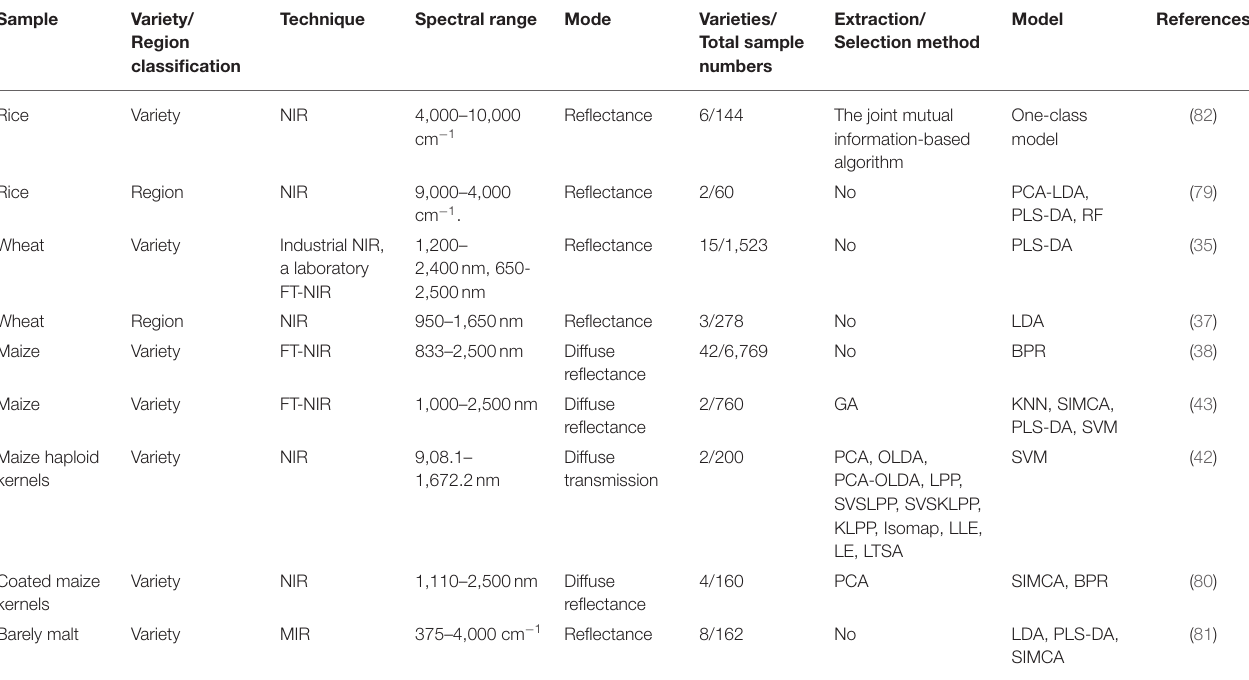
TABLE 1 | Summary of selected references for crop food classification with visible/infrared spectroscopy.